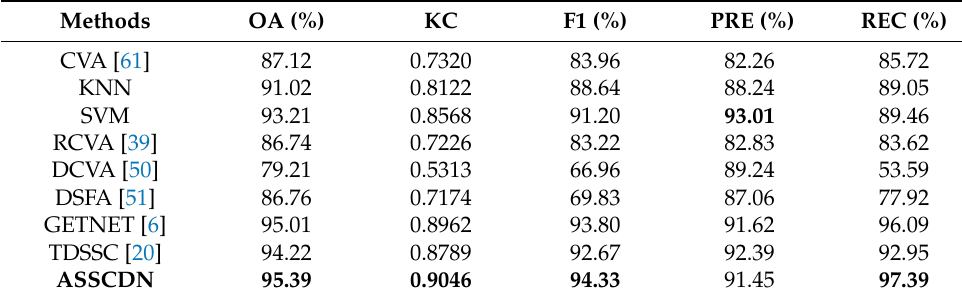
Table 2. Quantitative comparison results of various methods applied on the Barbara